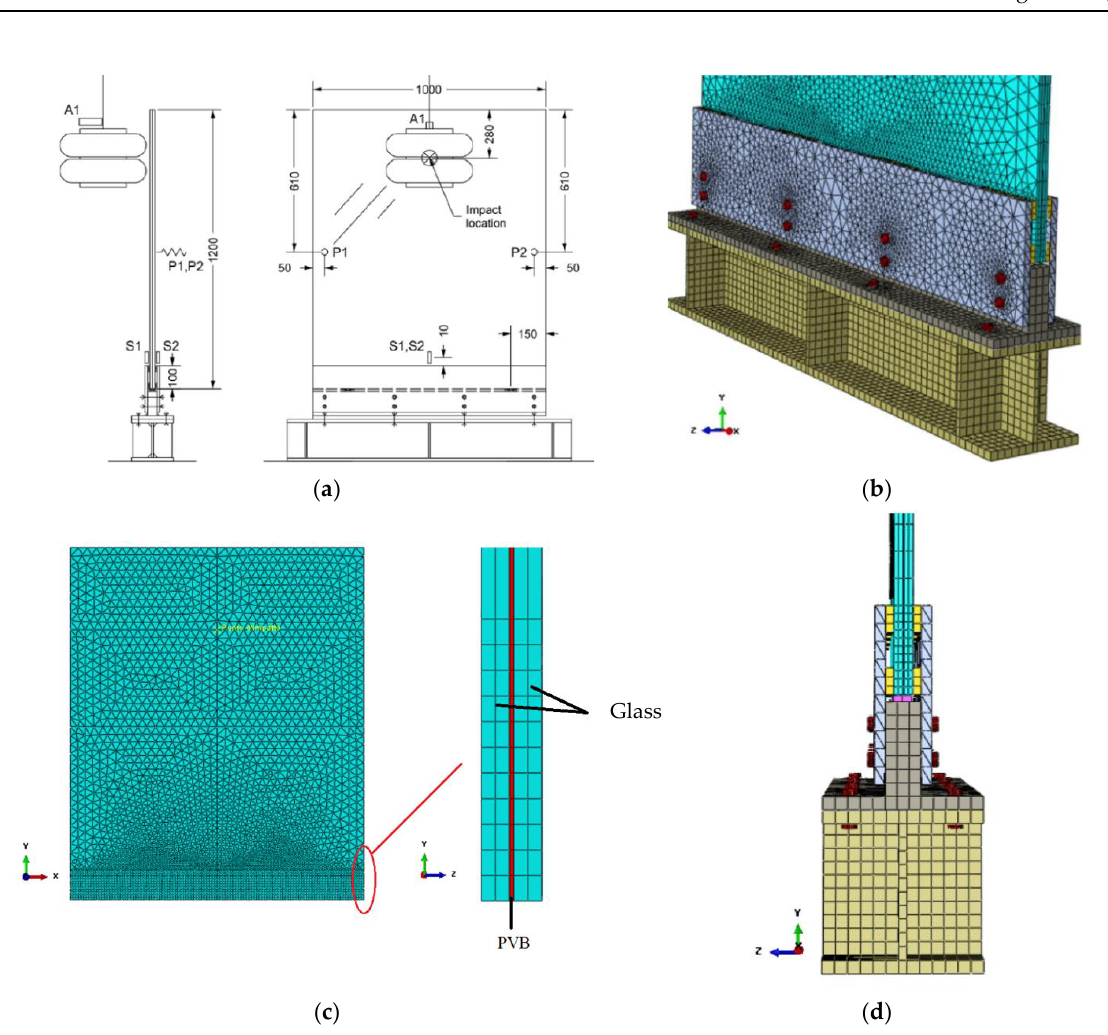
Figure 4. ( a ) Experimental setup (based on [17]), with dimensions in mm, and ( b – d ) detailed views of the presently developed “Refined” FE numerical model (ABAQUS).